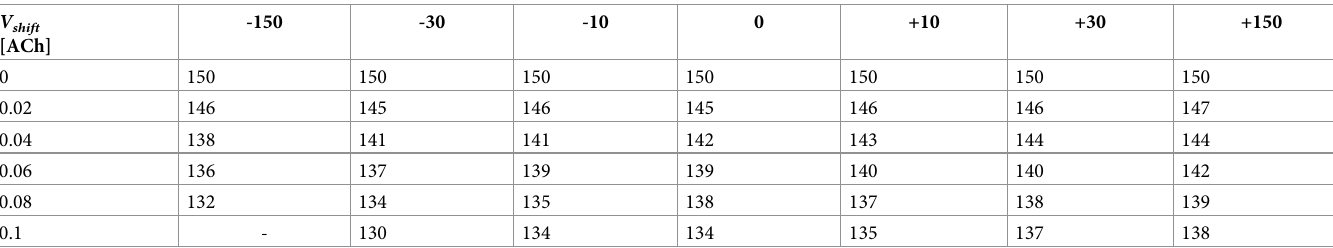
These experiments indicated that the affinity of the receptor for ACh was greater at hyperpo- larized membrane voltages, compared to depolarized voltages. We reasoned that, similar to voltage-gated ion channels, putative disease-associated mutations in M2R might alter the volt- age sensitivity of the M2R, with unique consequences for sinus node AP properties and heart rate responses. We modified rate parameters (Eqs 5 and 6) to shift the receptor occupancy towards a hyperpolarized state (higher affinity) or a depolarized state (lower affinity) (S1A Fig). Thus, we simulated the effects of shifting the M2R voltage sensitivity (Fig 2, S3C Fig). S1B Fig highlights the effects of voltage shifts on the state O. Negative shifts (e.g., V of -30 mV shift and -150 mV), which caused a more hyperpolarized state of the receptor, increased the occu- pancy of the U1 and B1 states, as well as the state O. Negative voltage shifts resulted in a slight leftward shift in the concentration-response curve when the cell was held at +50 mV (Fig 3E). Likewise, positive shifts in M2R voltage sensitive parameters caused a slight rightward shift in the concentration-response curve for a holding potential of V = -100 mV (Fig 3A). To avoid h local minima during the parameter fitting, the model was forced to favor the open state (state Table 2. APD 90 (ms) at different concentrations of ACh ( μ M) and shifts in the voltage affinity of M2R (mV). V shift